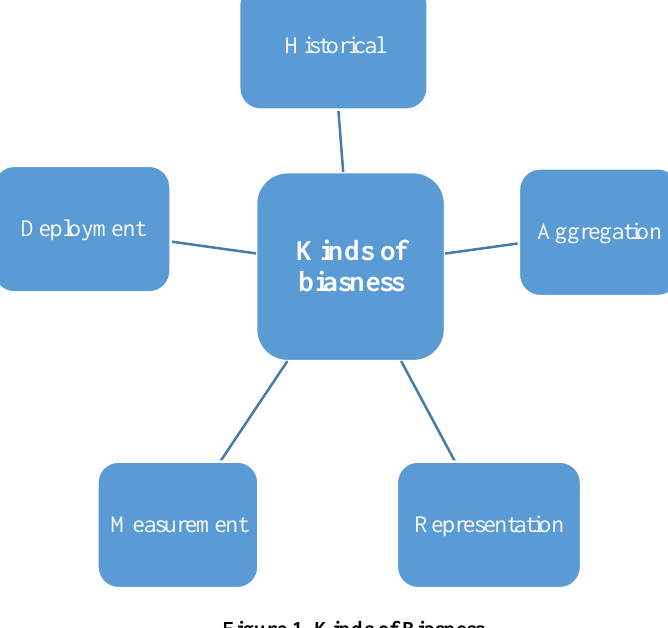
Figure 1. Kinds of